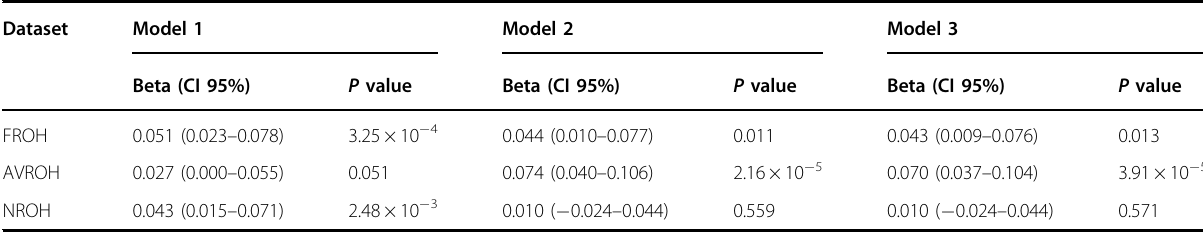
Table 1 Effect of genome-wide homozygosity measures in Alzheimer ’ s disease for the joint analysis.